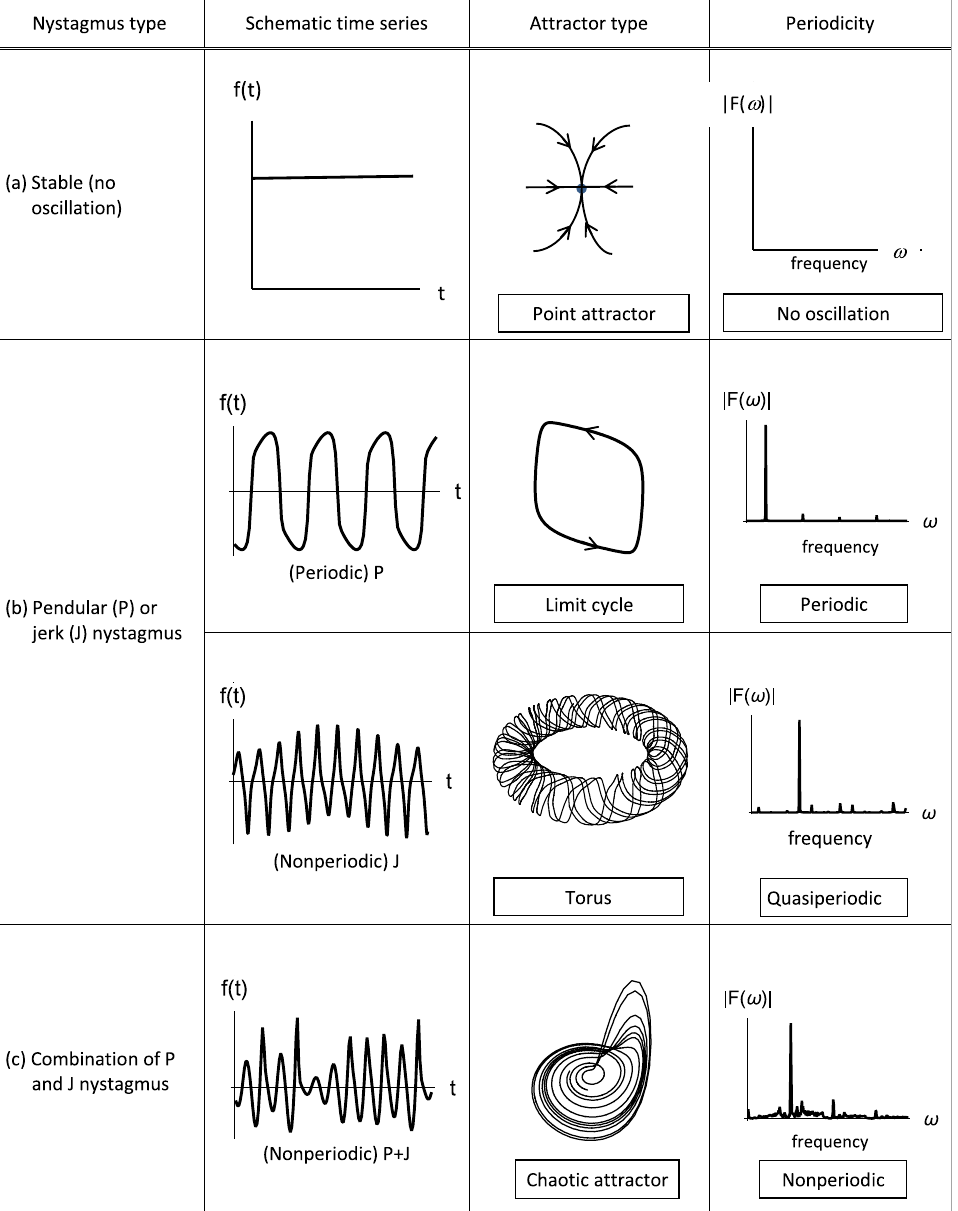
Figure 2. A comparison between stable (first row ( a )) and unstable fixation (second row ( b ) and third row ( c )). Columns 2, 3 and 4 show the corresponding time series, attractor type and frequency spectra, respectively. Note that all phase trajectories converge to the attractor over time: ( a ) A system in a state of stable equilibrium ( e.g. steady fixation) is represented by a fixed point. Unstable systems (giving rise to unsteady fixation) are illustrated by (( b )-top) a one-dimensional limit cycle (periodic oscillation), (( b )-bottom) a two-dimensional torus (quasiperiodic oscillation) and ( c ) a higher-dimensional chaotic attractor (nonperiodic